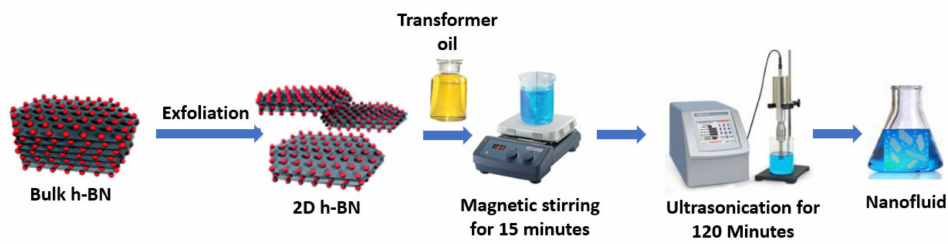
Figure 4. Schematic diagram of the preparation method of the 2D h-BN/transformer oil